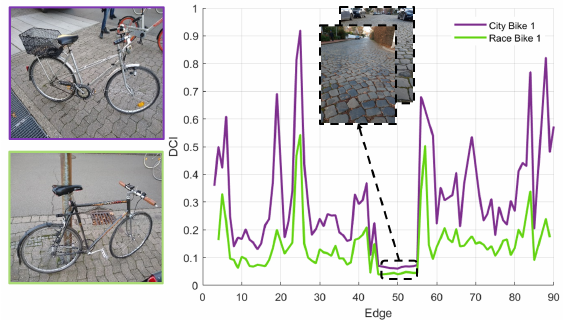
Figure 8. Comparison between a city bike and a racing bike regarding the DCI. On the x-axis the ridden edges of the test route are sorted by the visit